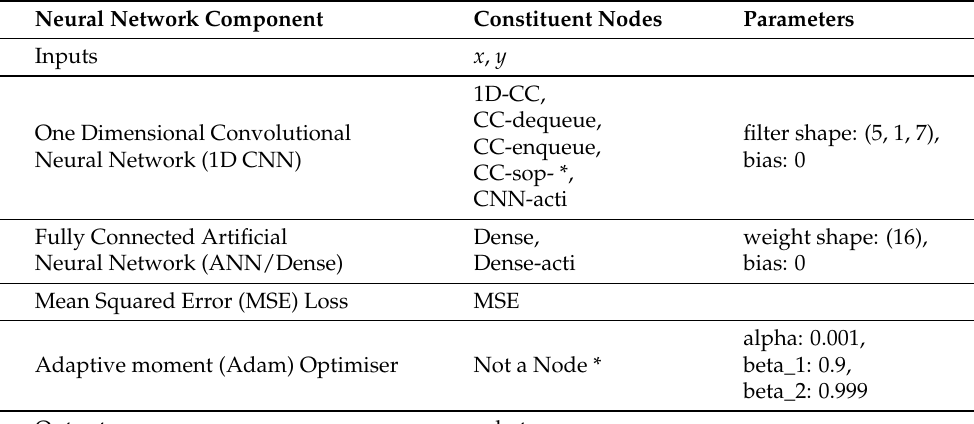
Table 1. Tabular-summarised neural network architecture, outlining the neural network components and how they are constructed using various constituent nodes, along with the parameters these nodes received such as filter shapes to randomly initialise the weights.